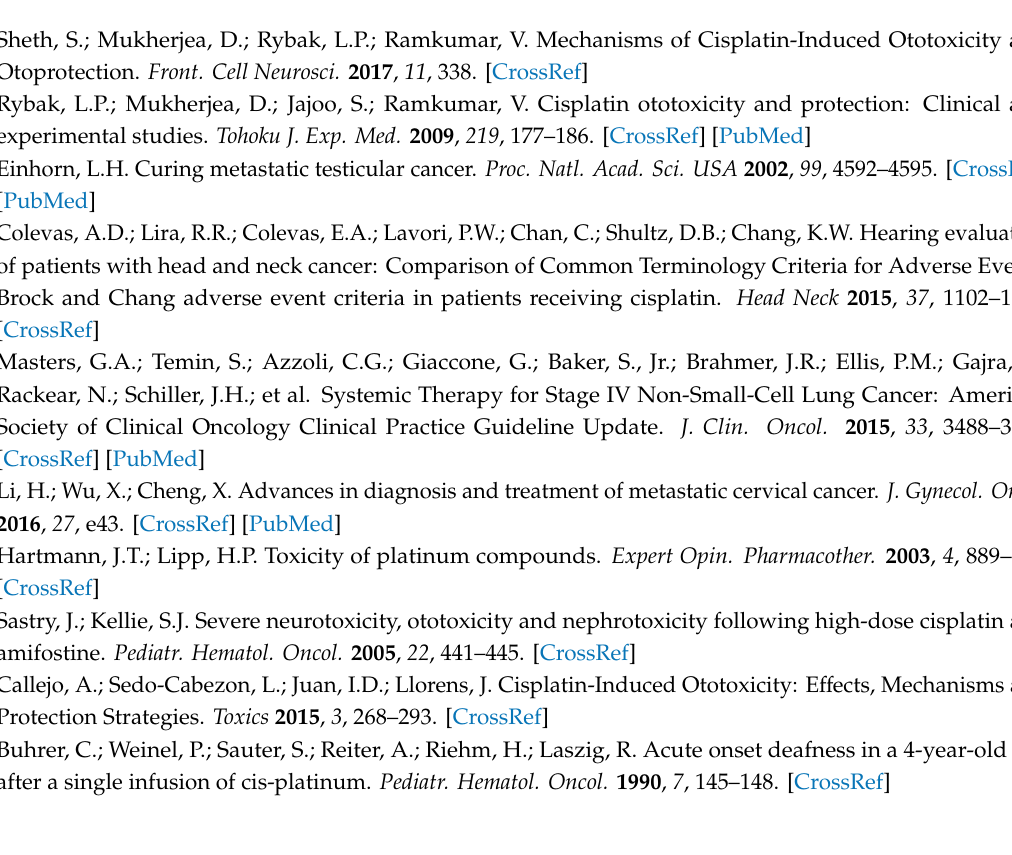
Figure S1: CYM-5478 does not protect cochlear neuroepithelial OC-k3 cells from cisplatin toxicity, Figure S2: Western blot of lysates from CLU188 cells with α -phospho-STAT3, Figure S3: Western blot of lysates from 4T1 cells with α -phospho-STAT3, Figure S4: Western blot of lysates from CLU188 cells with α -STAT3, Figure S5: Western blot of lysates from 4T1 cells with α -STAT3, Figure S6: Western blot of lysates from CLU188 cells with α -BCL-xl, Figure S7: Western blot of lysates from 4T1 cells with α -BCL-xl, Figure S8: Western blot of lysates from CLU188 cells with α - β actin corresponding to the α -BCL-xl blot, Figure S9: Western blot of lysates from 4T1 cells with α - β actin corresponding to the α -BCL-xl blot, Figure S10: Western blot of lysates from CLU188 cells with α -Bax, Figure S11: Western blot of lysates from 4T1 cells with α -Bax, Figure S12: Western blot of lysates from CLU188 cells with α - β actin corresponding to the α -Bax blot, Figure S13: Western blot of lysates from 4T1 cells with α - β actin corresponding to the α -Bax